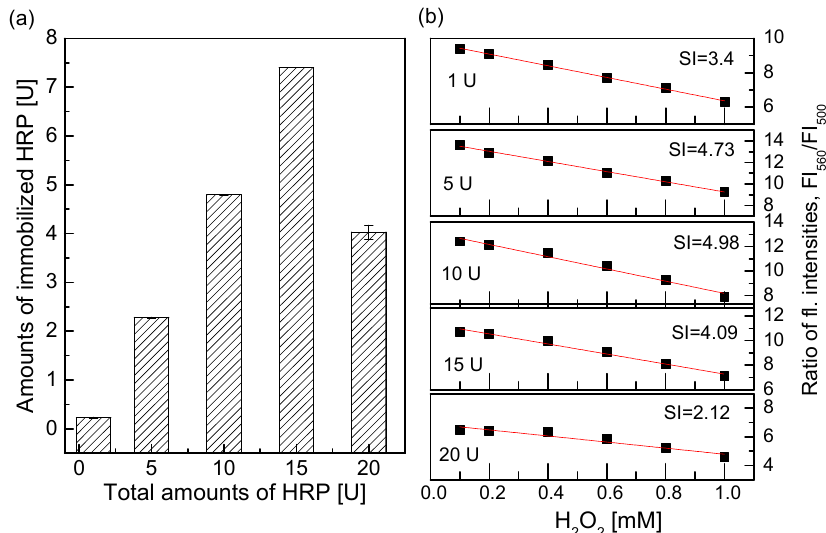
Figure 6. ( a ) Different amounts of HRP immobilized on the ethyl cellulose (EC) layer. ( b ) Response of the HRP–QD–AF membrane immobilized with various amounts of HRP. The sensitivity index (SI) represents the slope value, which indicates the sensitivity of the HRP–QD–AF membrane.